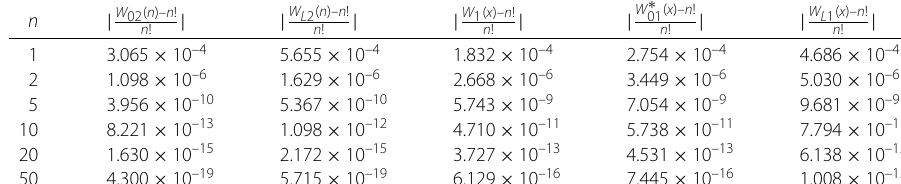
(1.10) and W L 1 01